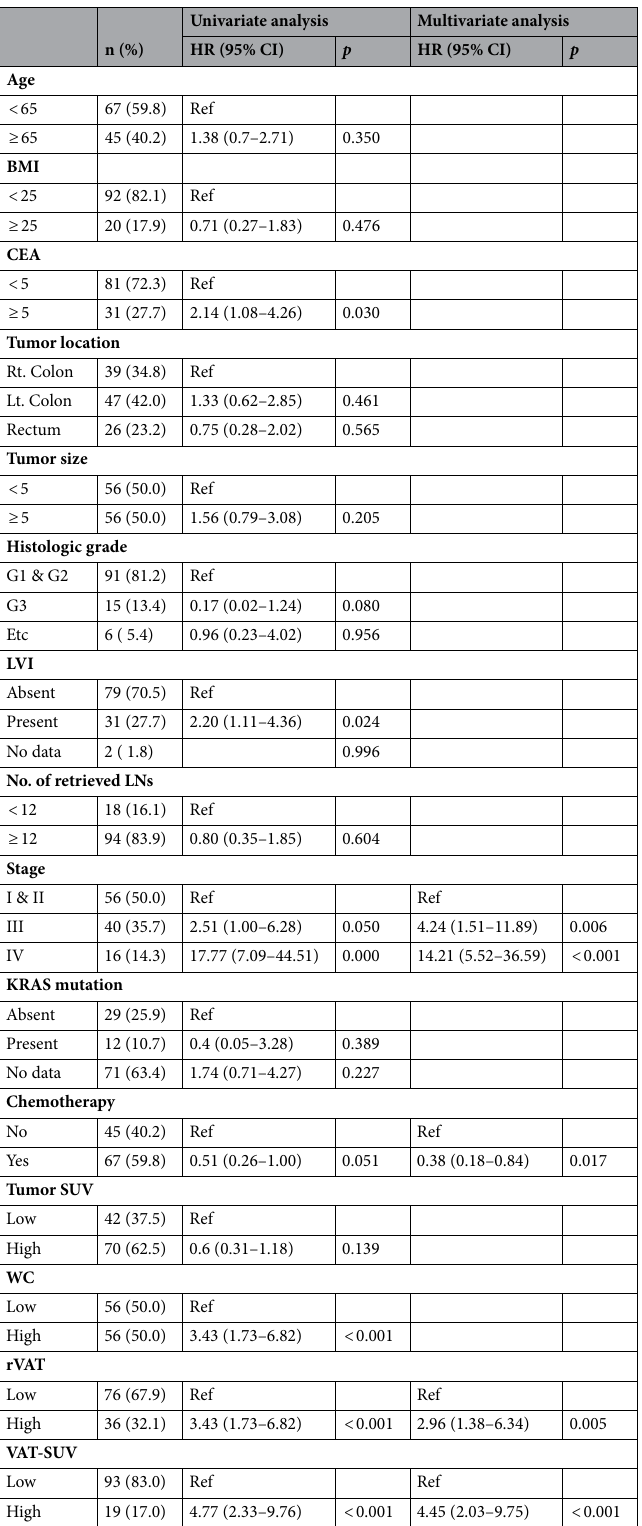
Table 3. Univariate and multivariate analyses in females (n = 112). ASA = American society of anesthesiology, BMI = Body mass index, CEA = Carcinoembryonic antigen, LN = Lymph node, LVI = Lymphovascular invasion, SUV = Standardized uptake value, rVAT = volume ratio of visceral adipose tissue (VAT) to total adipose tissue, WC = waist